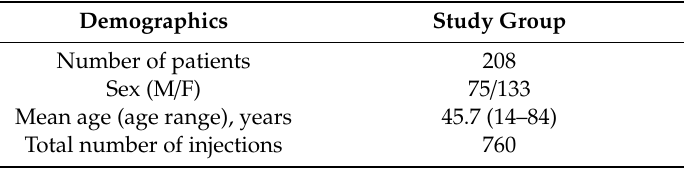
Table 1. Demographic data of the study